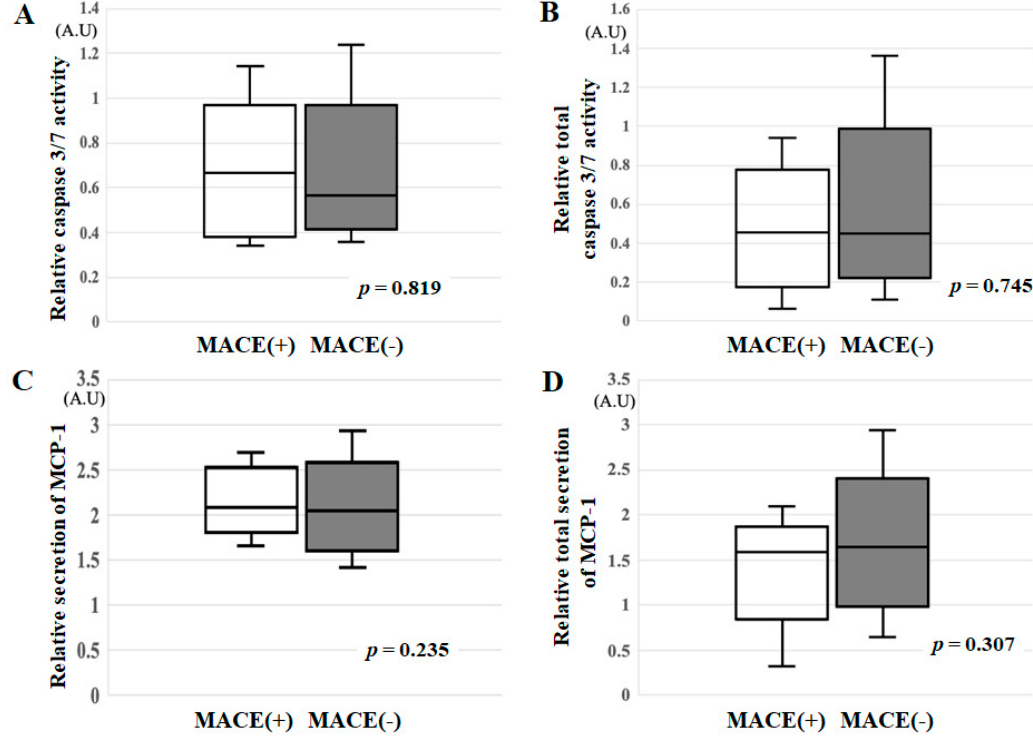
Figure 2. ( A ) Relative caspase 3/7 activity, ( B ) relative total caspase 3/7 activity, ( C ) relative secretion of MCP-1 and ( D ) relative total secretion of MCP-1 in the MACE(+) and MACE( − ) groups. A.U : arbitrary unit.